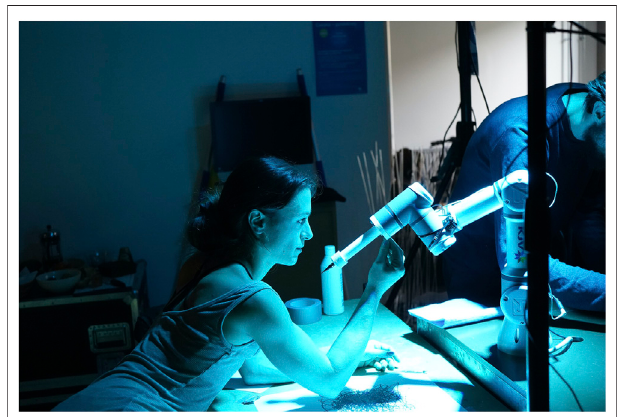
FIGURE 9 | Rizzo works with the robot during a puppetry workshop at the RELATE lab. Using physical manipulation, EMCAR allowed the artist to work directly with the robotic arm to choreograph, record and playback animation